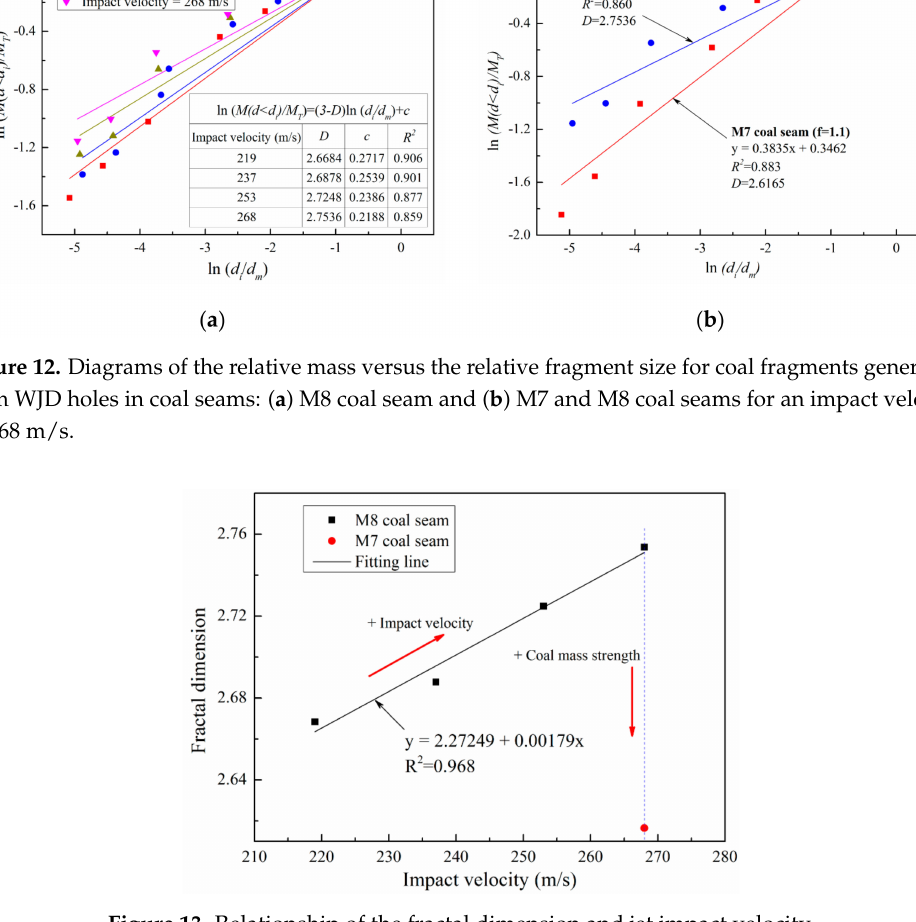
Figure 13. Relationship of the fractal dimension and jet impact velocity. Table 4. Relationship between the fractal dimension and dominant fragment